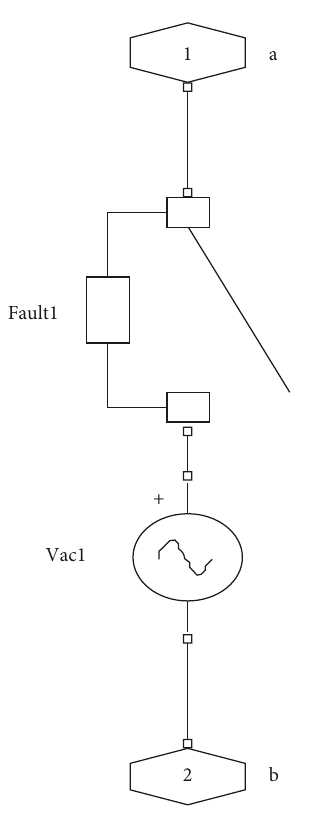
Figure 10: Structure of voltage swell simulator.